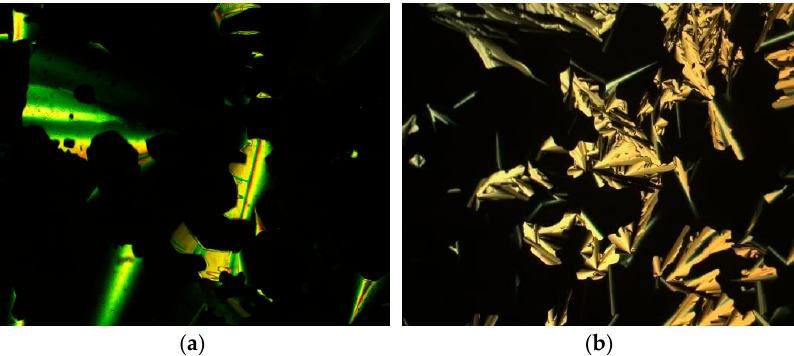
Figure 5. ( a ) The cubic phase growing in from Col h phase of compound 4 -10 at 108 °C and ( b ) the Col h phase formed by compound 4 -12 at 172 °C.